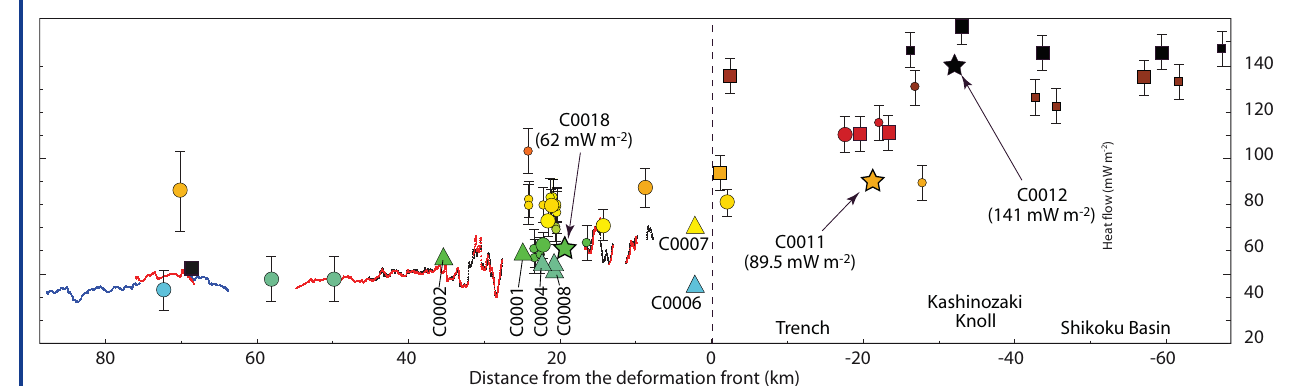
Figure 5. Heat-flow data collection in a 10-km-wide swath along the Kumano transect. Squares are heat flow probe measurements from Kinoshita et al. (2008), circles are long-term measurements from Hamamoto et al. (2011), triangles are borehole measurements from IODP Exp. 315 and 316, stars are from Exp. 333. The symbol sizes indicate data quality as defined by authors (big: good to excellent; small: poor to fair), the symbol color is a function of the heat flow value. Values derived from Bottom Simulator Reflectors (BSRs) along sections of multichannel seismic lines are plotted as